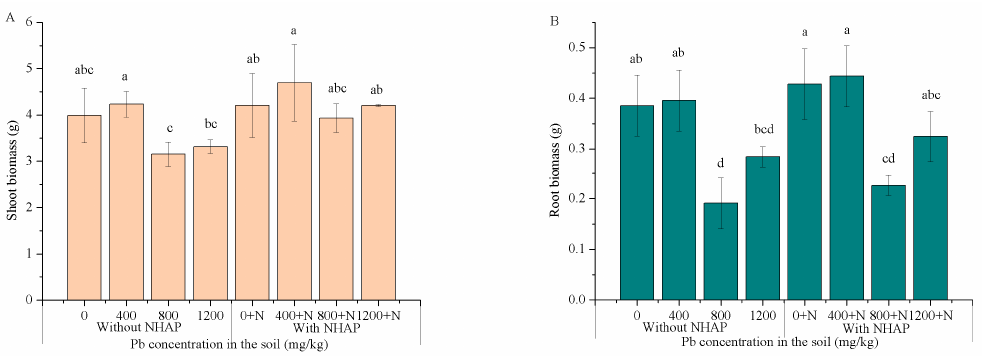
Figure 3. Effect of NHAP in different treatments on ryegrass shoot ( A ) and root ( B ) biomass. a, b, c, d: The different letters in the table represent significant differences between treatments at p < 0.05.